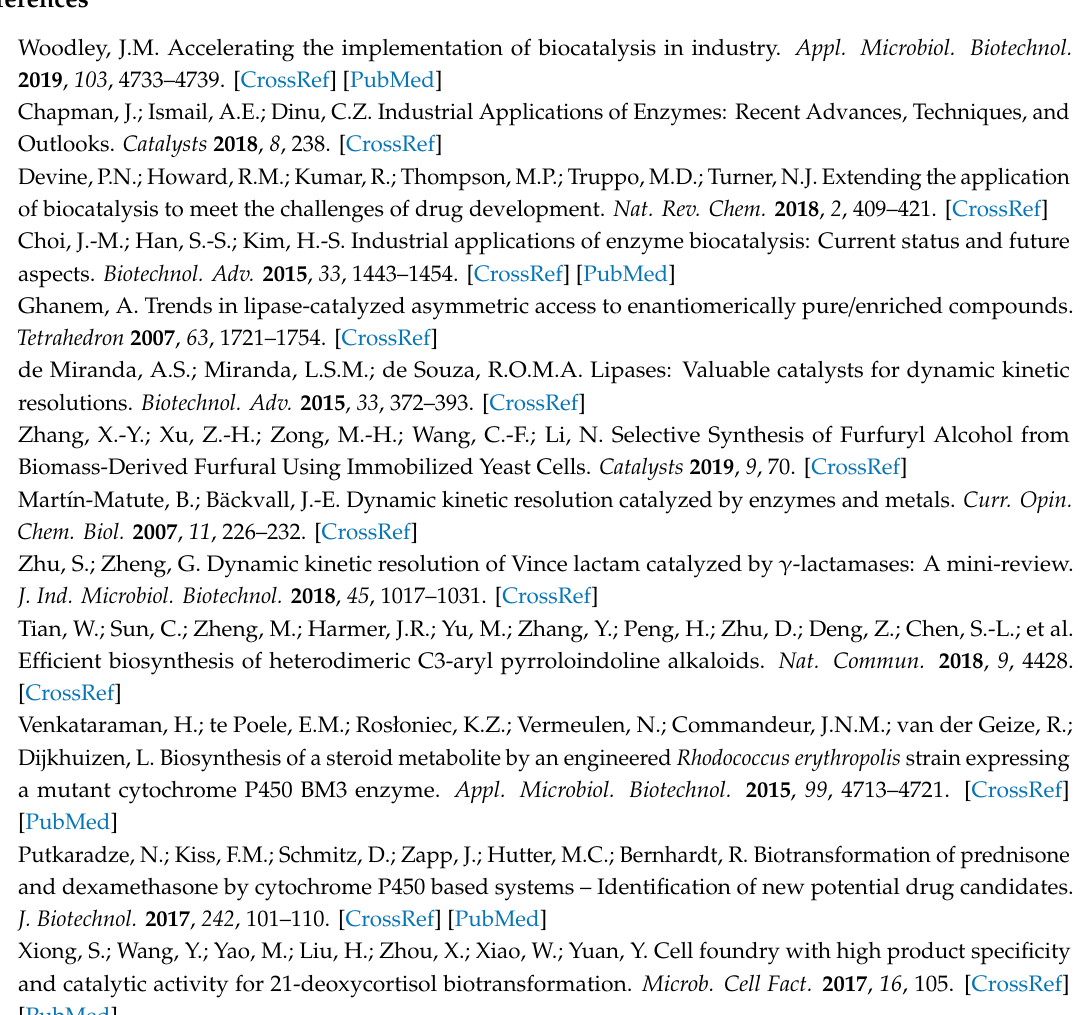
acid; Figure S2. Representative HPLC chromatogram from the separation of D- and L-phenylalanine; Figure S3. Monitoring the selective immobilization of Pc PAL (78 kDa, green framed) onto cobalt contained bifunctional magnetic nanoparticles by SDS-PAGE; Figure S4. Monitoring the selective immobilization of Pc PAL onto cobalt contained bifunctional magnetic nanoparticles; Table S1. Estimation of immobilized target protein quantity based on the activity values were measured during the immobilization